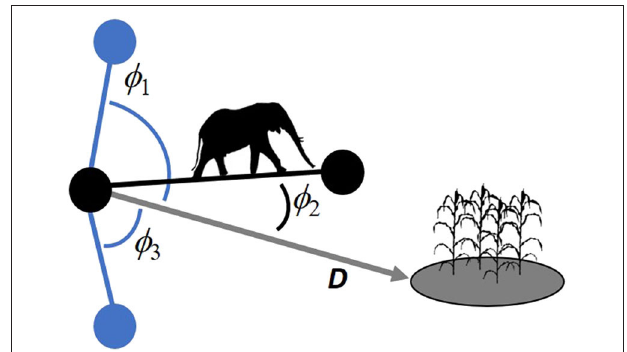
FIGURE 2 | Example of observed (black to black patch) and potential (black to blue patch) interpatch movements, with associated measurements for the difference between the direction of an interpatch movement and the nearest conflict zone ( φ i , where φ 1 and φ 3 are associated with untraveled but available interpatch movements and φ 2 is associated with the observed movement), and the Euclidean distance to the conflict zone ( D